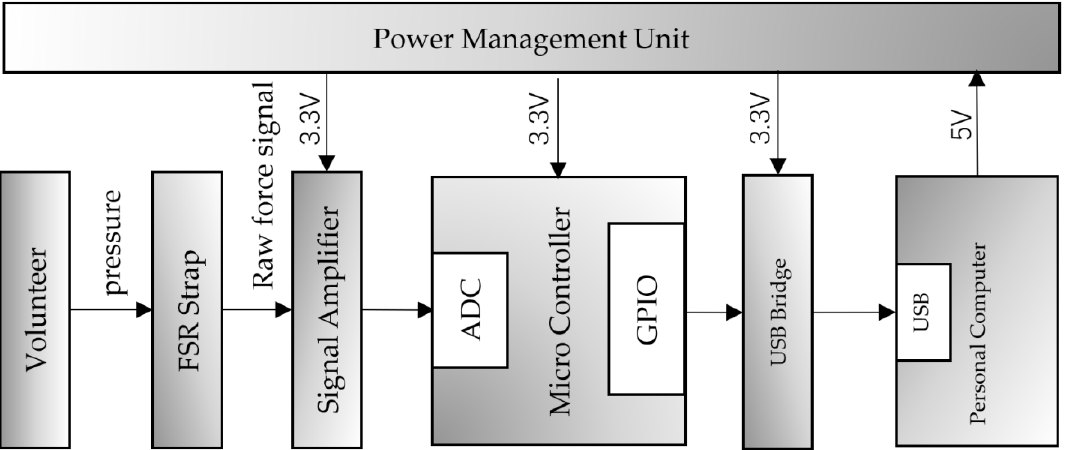
Figure 1. The hardware architecture for FMG acquisition.